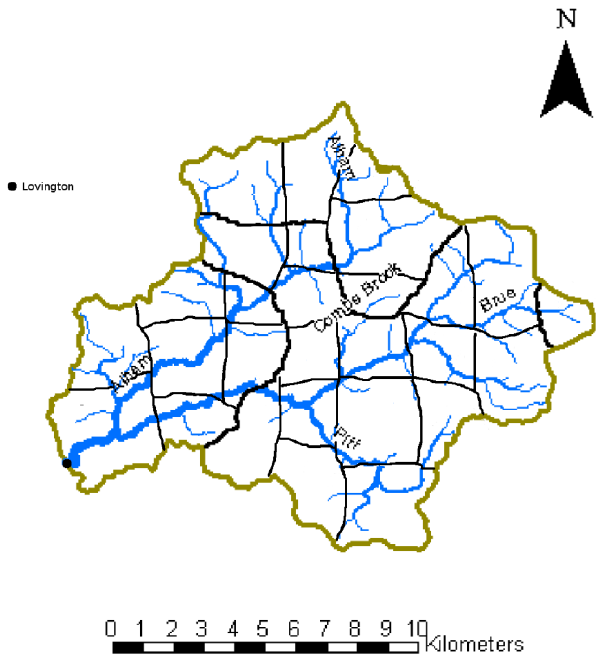
Fig. 2. The Brue catchment and the location of the 28 rain areas Fig. 2 The Brue catchment and the location of the 28 rain areas (black lines) and the 967 (black lines) and the Lovington flow gauge (black dot). Lovington flow gauge (black dot). 968